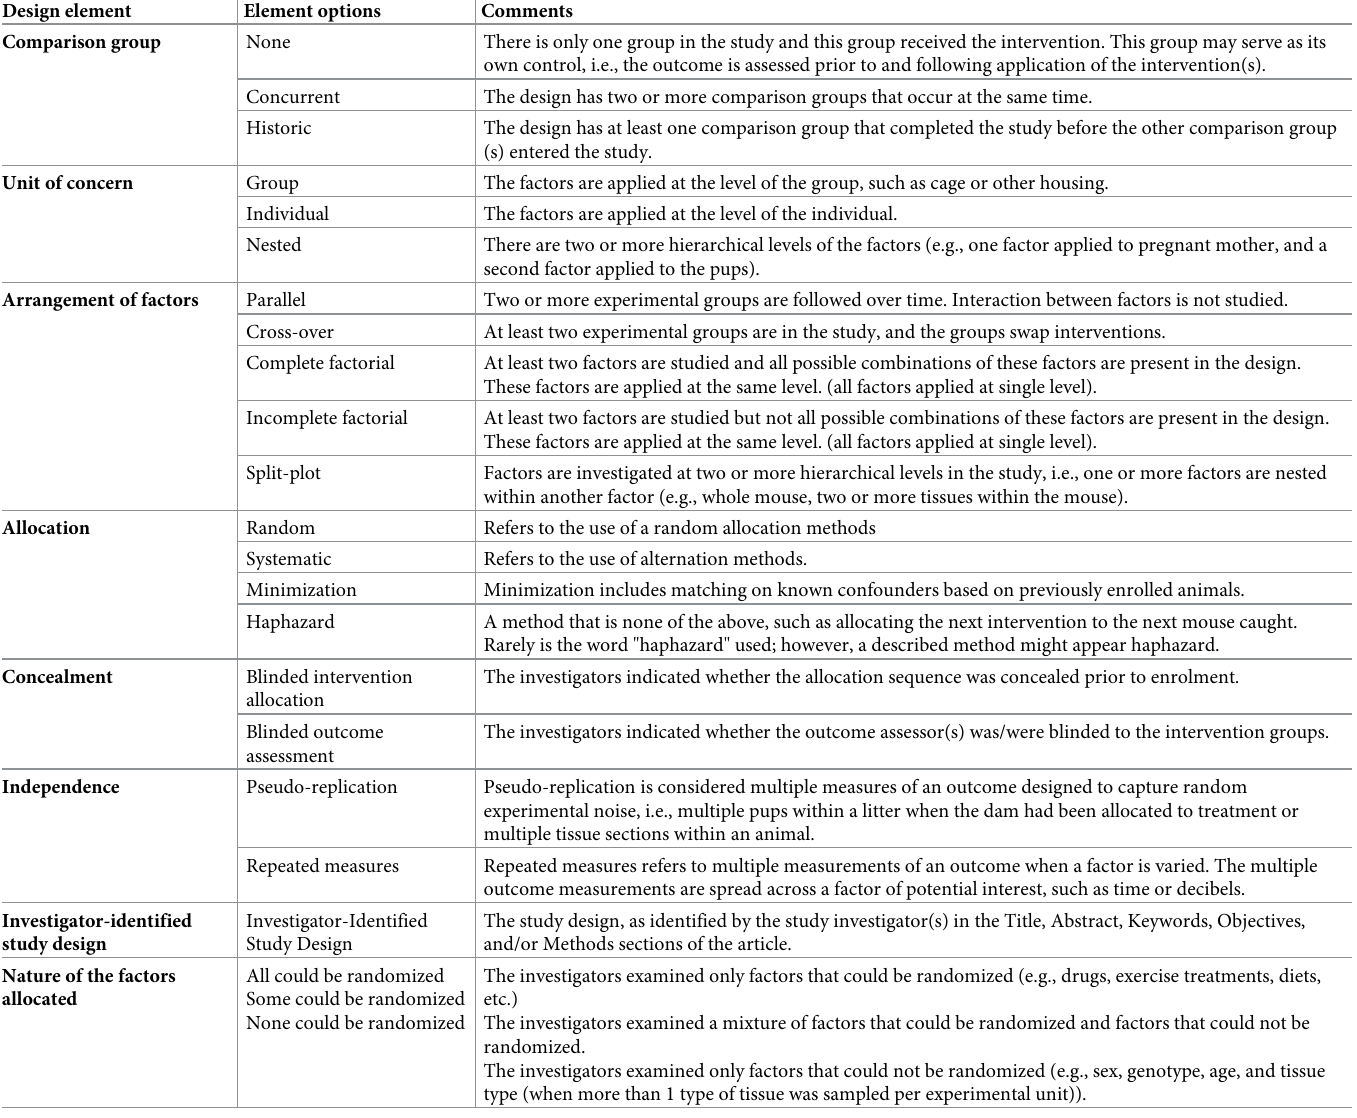
Table 1. Design element groups and annotation options for use with an AFLEX (automatic functional language recognition/EXtraction) interface for annotating portable document format files. Design